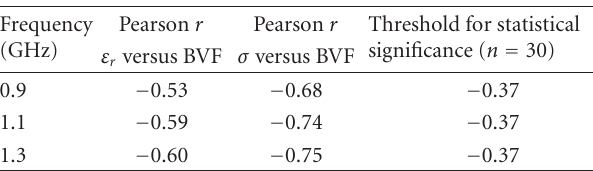
Table 1: Values for Pearson product-moment correlation coe ffi - cient of the dielectric properties and